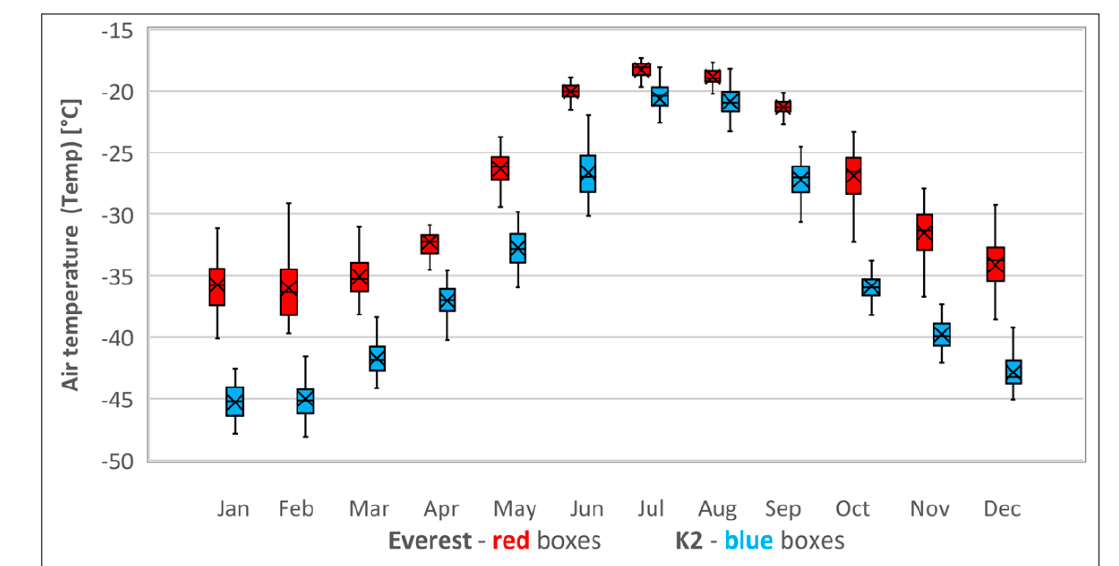
Figure 2. Annual cycle of air temperature (Temp) at the summits of Everest (red boxes) and K2 (blue boxes). Sample size - 41 monthly means (1979-2019). Bars extend to the maximum and minimum BP, boxes span the 25th–75th percentiles, crosses inside the boxes mark the monthly mean, and vertical lines inside the boxes represent the monthly median.